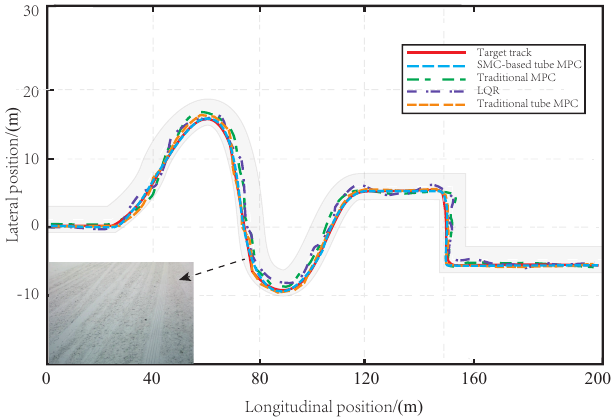
Figure 7. The path tracking effect on the snowy road.